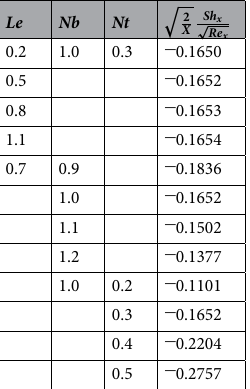
Table 3. Variation of Sherwood number with Le , Nb , and Nt